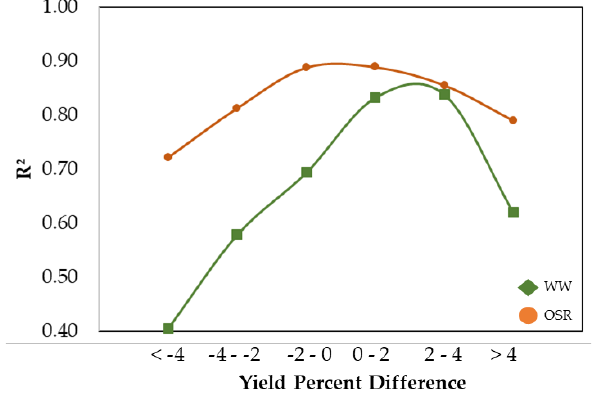
Figure 12. The dot plots show the district-wise distribution of modelled yield for ( a ) WW and ( b ) OSR, from 2001 to 2019. The green colour depicts the modelled yield of WW, the orange colour depicts the modelled yield of OSR, and the grey colour depicts both referenced yields of WW and OSR.